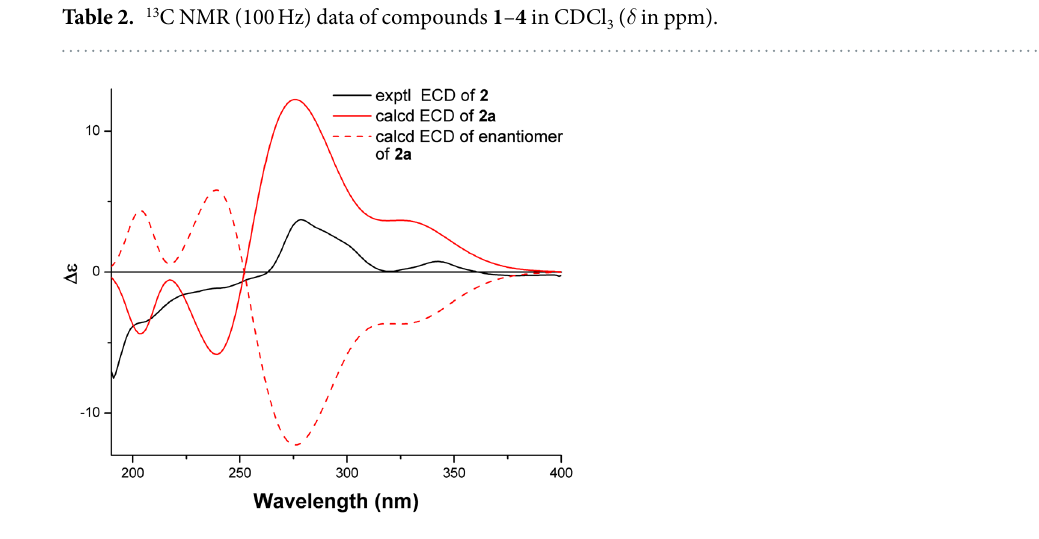
Figure 5. Experimental ECD spectrum of 2 and TDDFT calculated ECD spectra for 2a (1 R , 3 S , 4 R , 5 R , 6 R , 7 S , 10 R , 1 ′ R ) and enantiomer of 2a